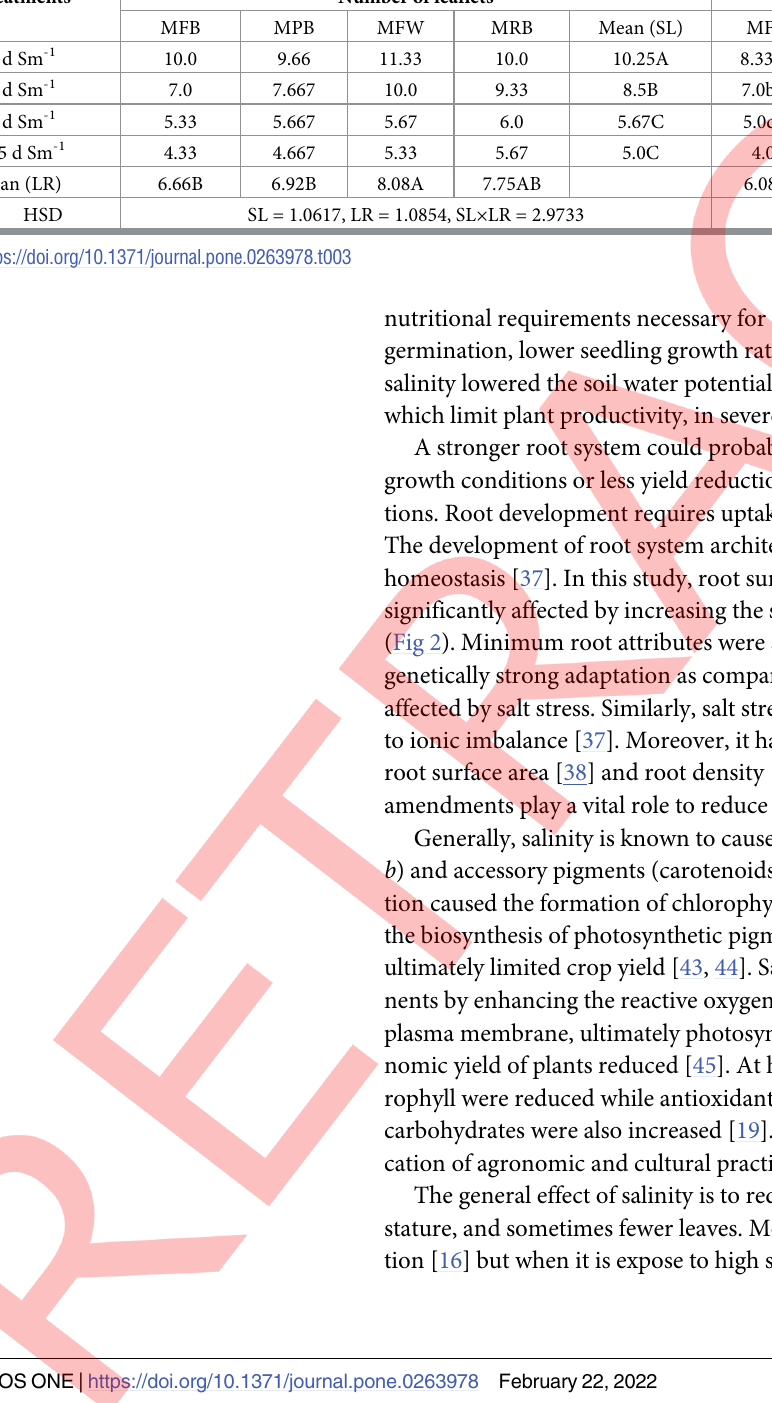
Table 3. Impact of various salinity levels on growth attributes of moringa landraces. Treatments